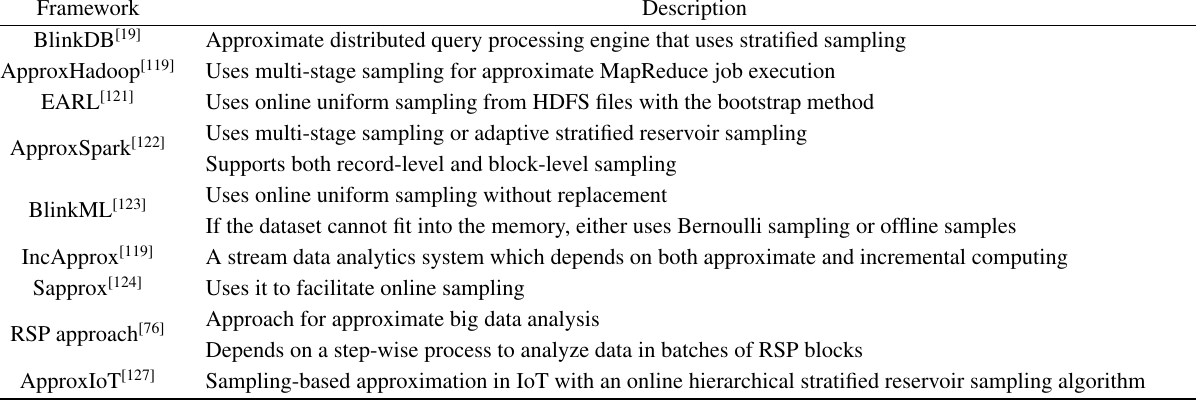
Table 3 A summary of frameworks for sampling-based approximation on Hadoop clusters. Framework